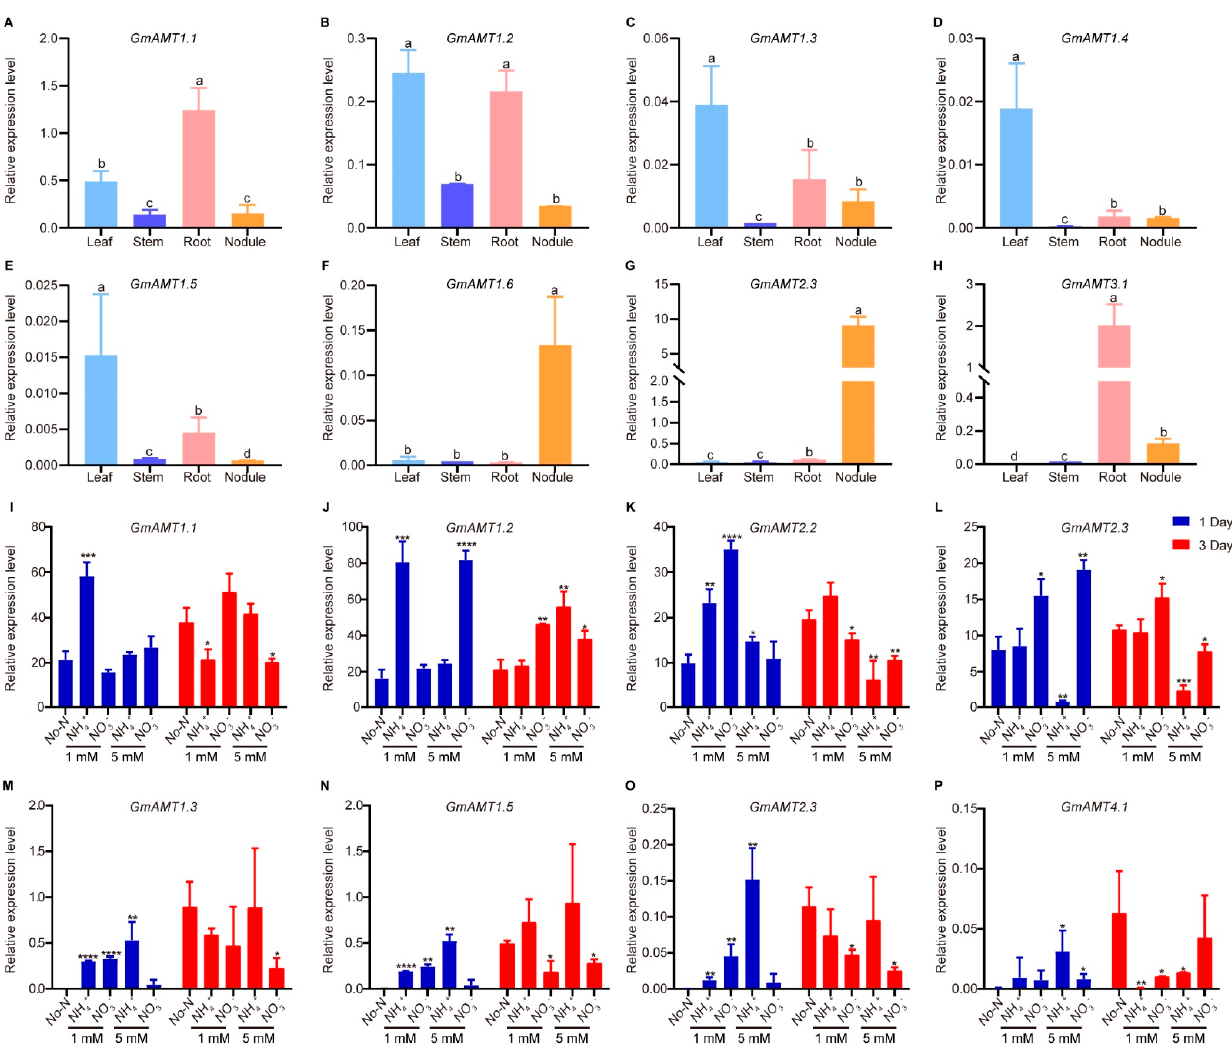
Figure 9. Gene expression analysis of GmAMTs in di ff erent tissues and in response to di ff erent nitrogen treatments by RT-qPCR. ( A – H ) Detection of GmAMT expression in leaves, stems, roots, and nodules at 24 days after rhizobial inoculation. The expression pa tt erns of GmAMTs were analyzed in roots ( I – L ) and leaves ( M – P ) under di ff erent nitrogen sources (NH 4+ -ammonium nitrogen, NO 3- - nitrate nitrogen, No-N: nitrogen free BD solution) and concentrations (1 mM and 5 mM) at 1 day (blue bars) or 3 days (red bars). GmELF1b was used as a reference gene. The relative gene expression levels were calculated using the method of 2 - ΔΔ Cq to express the ratio between the GmAMTs and reference GmELF1B . The data were analyzed using student’s t -test for signi fi cant di ff erences (*, p < 0.05; **, p < 0.01; ***, p < 0.001; ****, p < 0.0001). Di ff erent le tt ers represent signi fi cant di ff erences (Tukey’s test, p < 0.05).